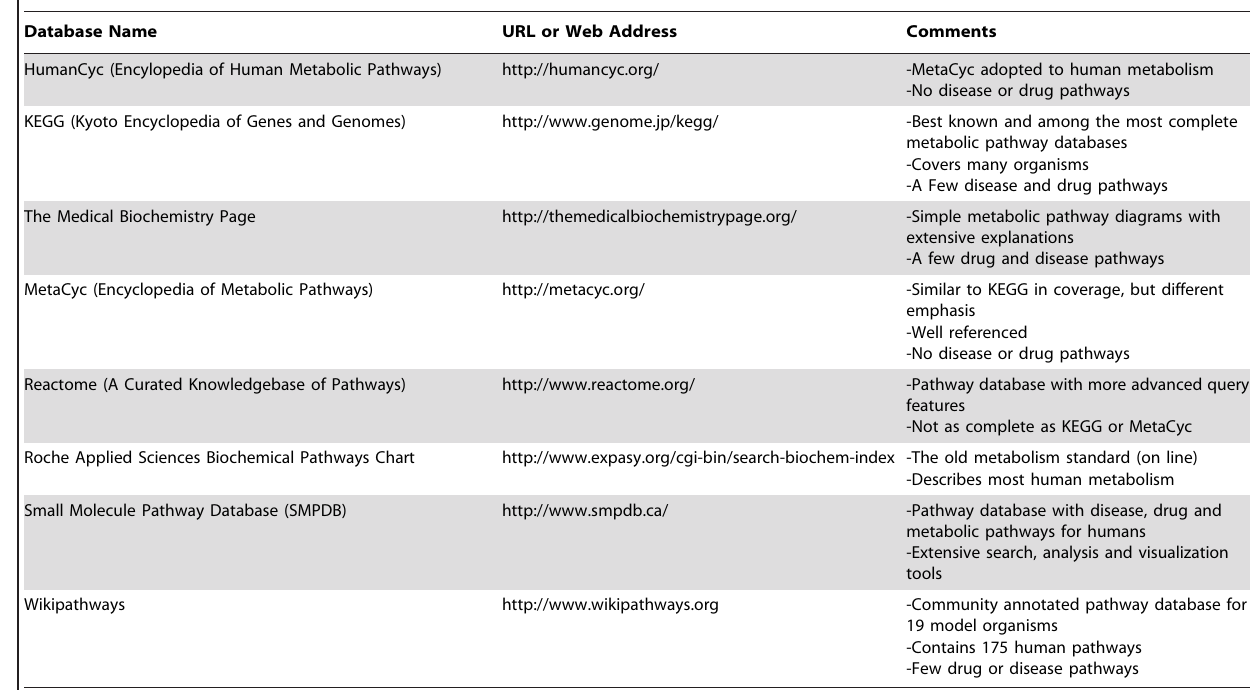
Table 1. Alphabetical List of Popular Metabolic Pathway